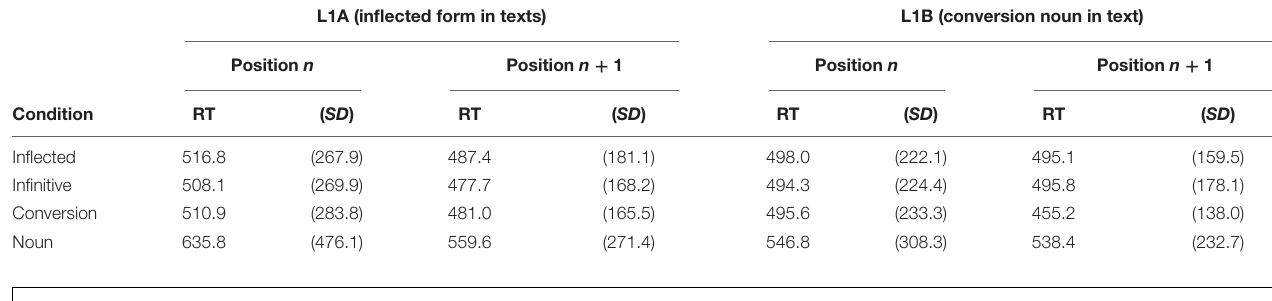
TABLE 3 | Results of Experiments L1A and L1B (mean RTs in ms and SDs).